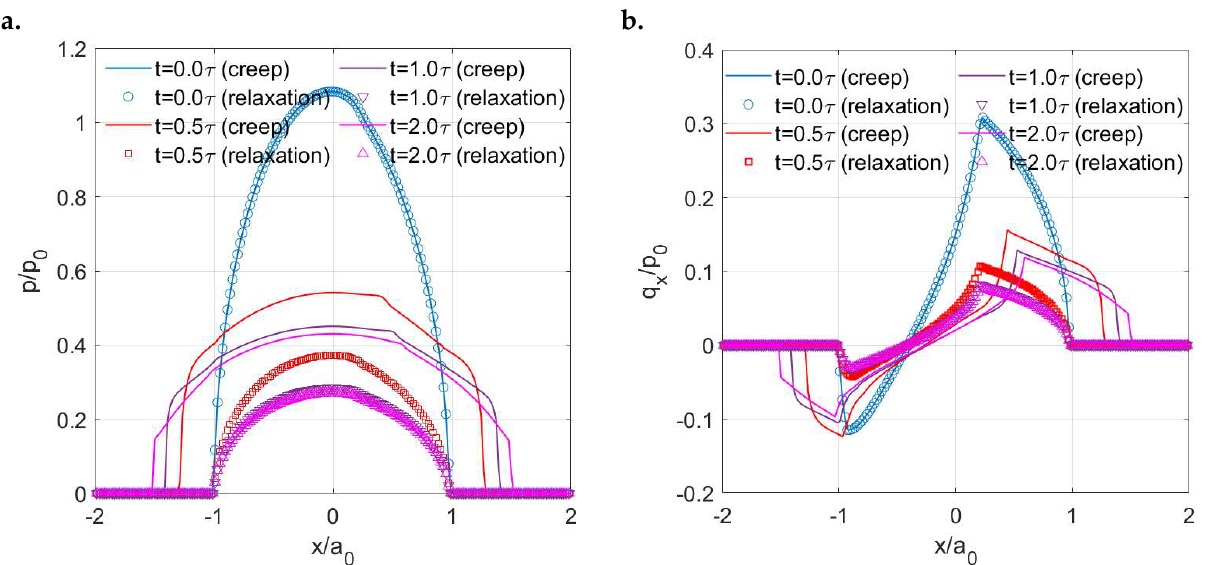
Figure 22. Changes in the contact tractions with time for the creep (solid line) and relaxation (scatter) cases: ( a ) pressure p along the x axis and ( b ) shear traction q x along the x axis.